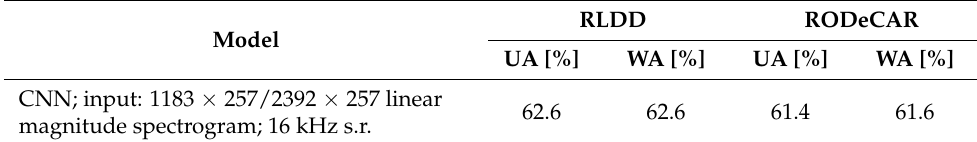
Table 10. CNN-based DSD cross-validation performance–RLDD and RODeCAR. RLDD RODeCAR Model UA [%] WA [%] UA [%]